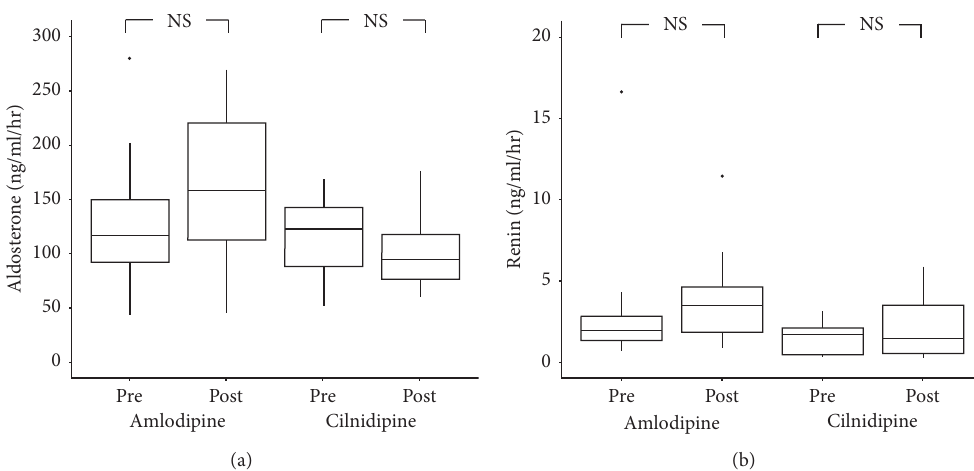
Figure 6: Plasma aldosterone levels and PRA before and after treatment. Although there were no significant differences in plasma al- dosterone levels of PRA between the 2 groups, both showed nonsignificant increases in the amlodipine group but not in the cilnidipine group. PRA, plasma renin